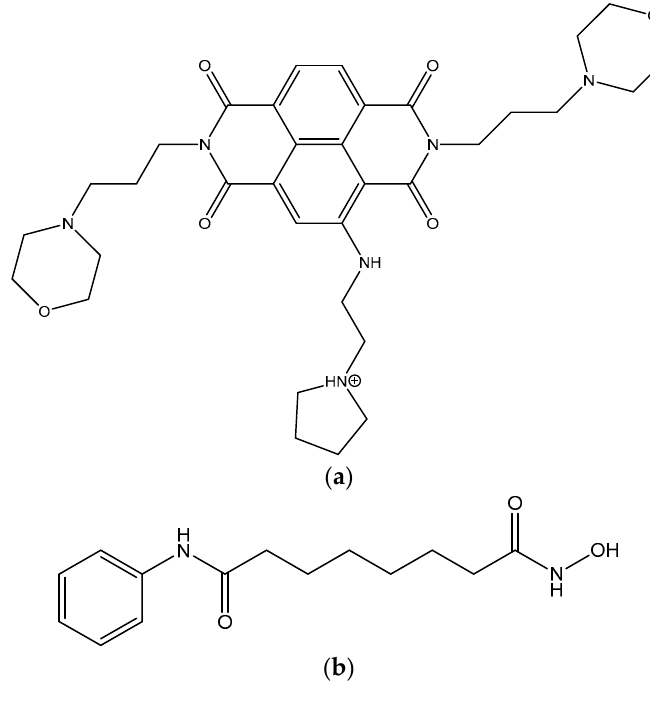
Figure 1. Structure of ( a ) CM03, ( b ) SAHA.